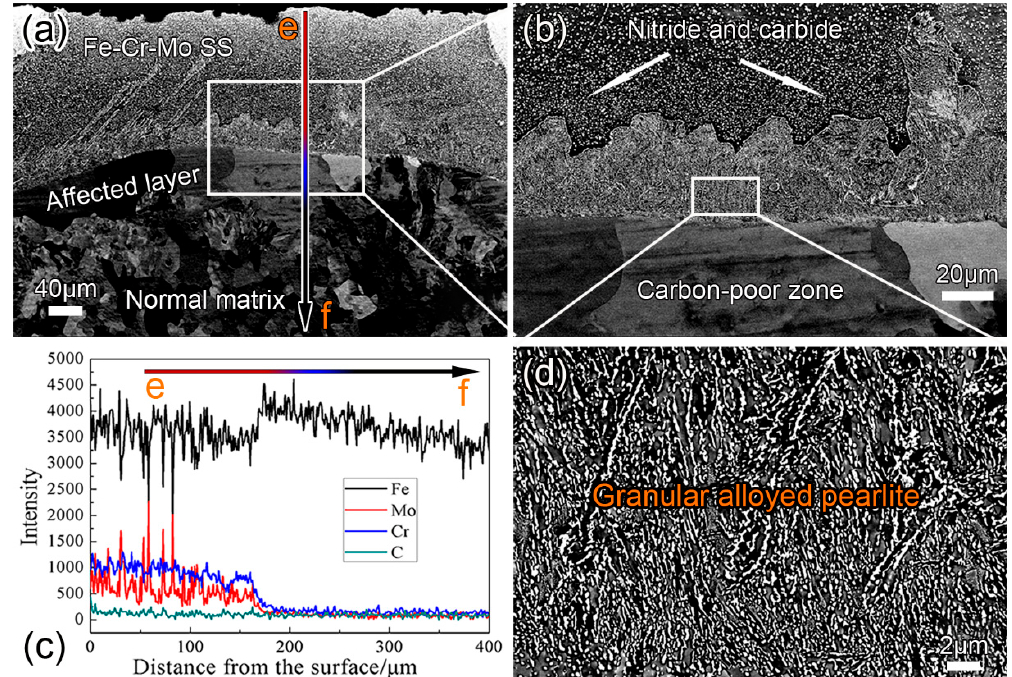
Figure 3. BSEI images and EDS patterns of the CrMo-6-A sample: ( a ) cross-sectional view showing the coatings; ( b ) is an enlarged view of the corresponding white box in ( a ); ( c ) EDS line scanning spectra; ( d ) is the corresponding part in the white box in ( b ).